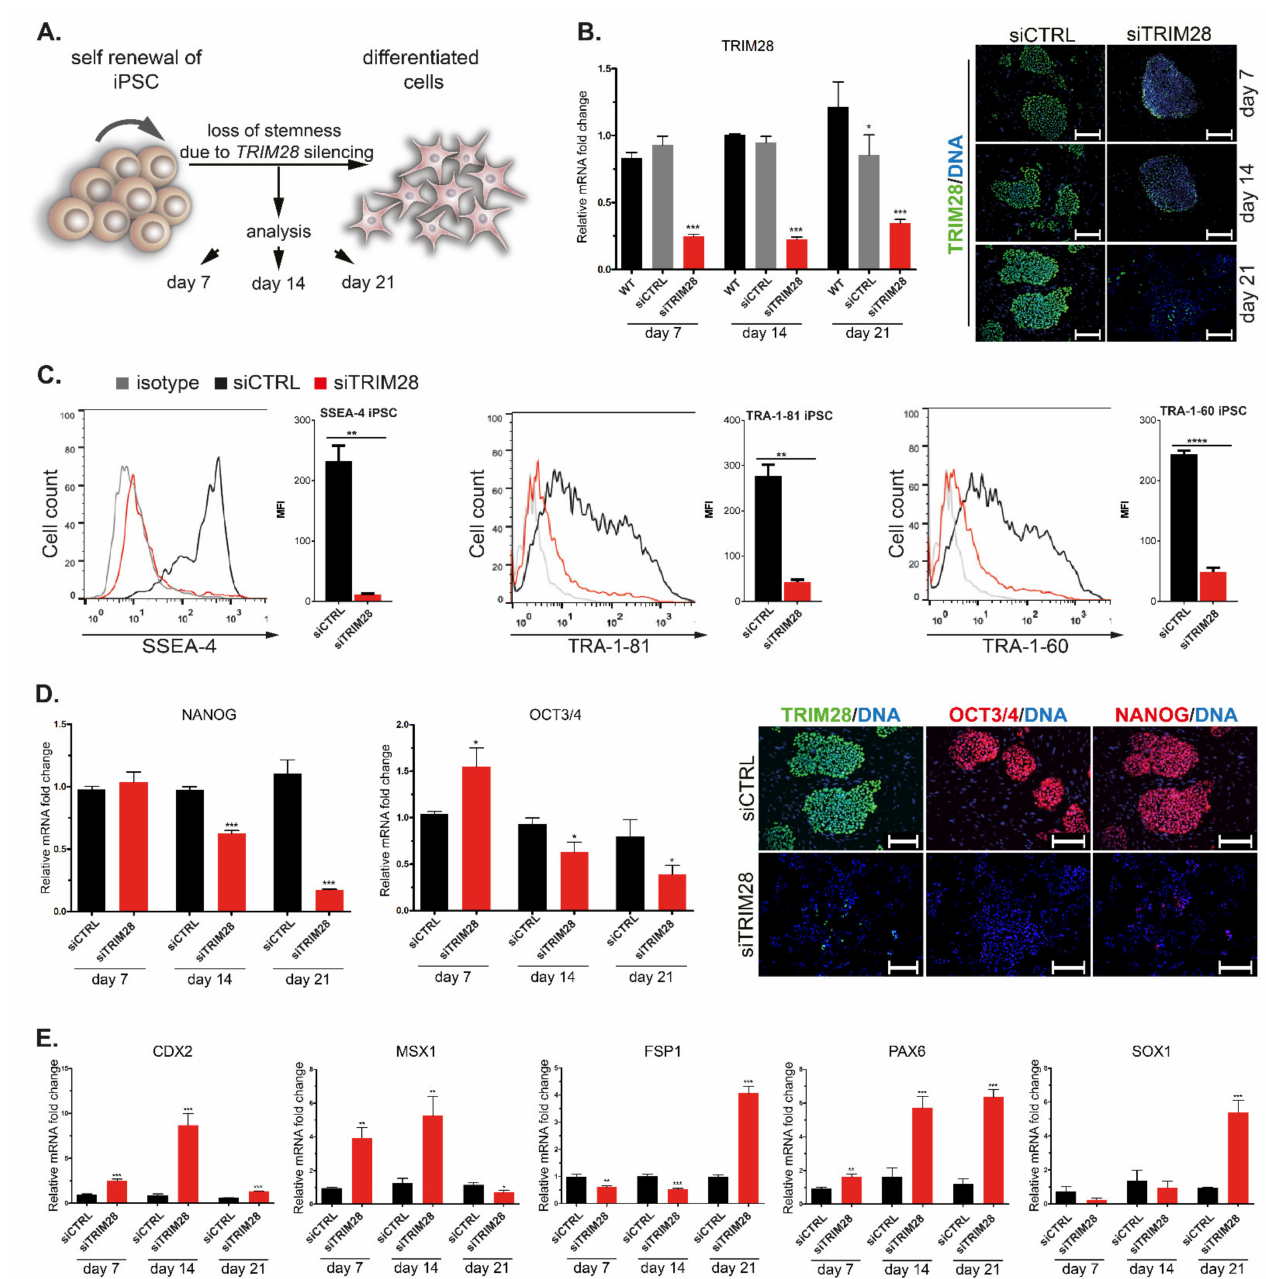
Figure 1. Silencing of endogenous TRIM28 induces downregulation of pluripotency markers and differentiation of human iPSC. ( A ) Endogenous TRIM28 was silenced in human iPSC with siRNA. Stemness and differentiation status were analyzed every 7 days for 3 weeks. ( B ) Silencing of TRIM28 at transcriptional and protein level confirmed by qRT-PCR (left) and immunofluorescence staining (right; green—TRIM28, blue—DAPI). Scale bar: 100 µ m. Representative images are shown in the figures. ( C ) Flow cytometry analysis revealed decreased expression of extracellular pluripotency markers SSEA-4, TRA-1-60, and TRA-1-81 in siTRIM28 iPSC (red) vs. CTRL iPSC (black). Isotype control is marked in gray. ( D ) The